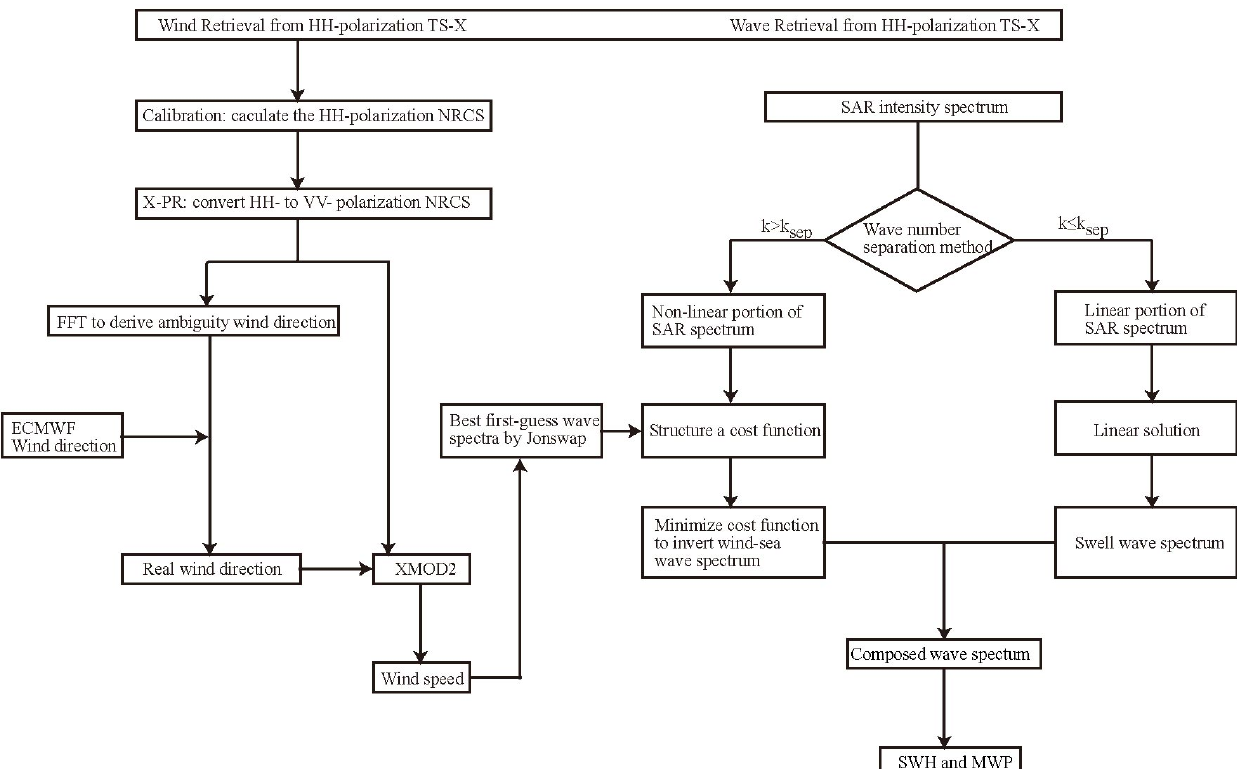
Figure 2. Block diagram of PFSM scheme for retrieving wind and wave from HH-polarization TS-X